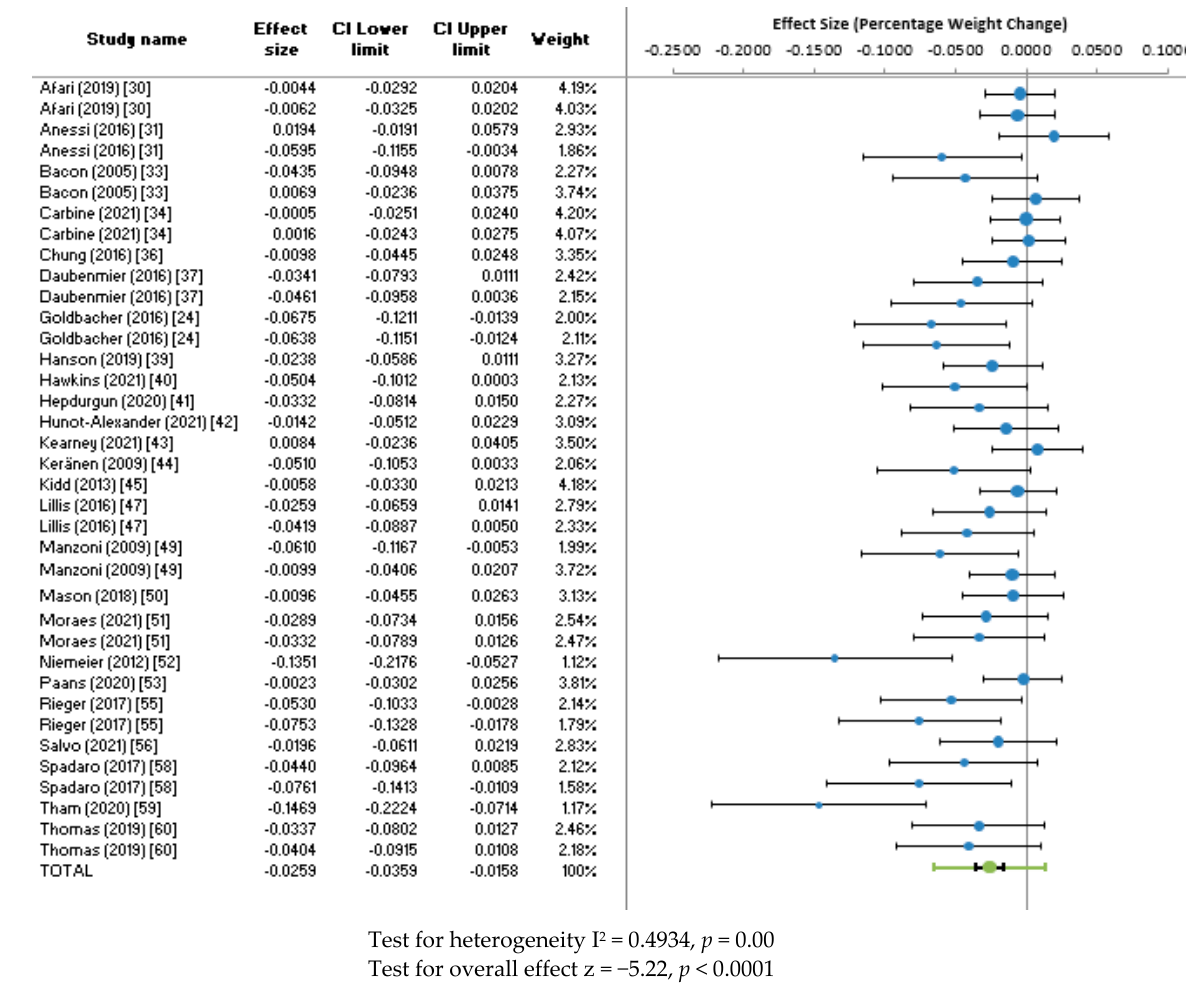
Figure 2. Forest plot for percentage weight change .